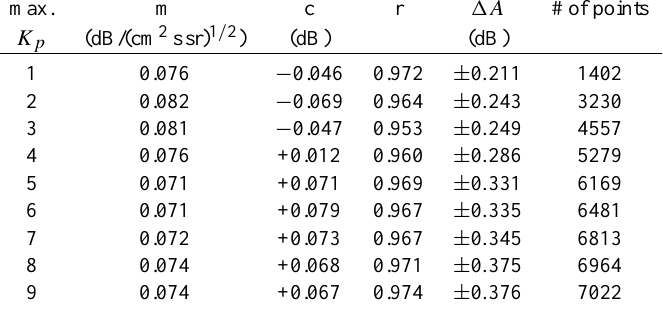
√ J(> 10 ) + c . Columns left to right display the maximum K p Table 3. Parameters of fits to the CNA and integral flux using the form: A = m of the data used, the gradient of the fit, the intercept, the correlation coefficient, least-squares fit error and the number of points used. max. m c r 1A # of points K p (dB/(cm 2 ssr) 1 / 2 ) (dB) (dB) 1 0.076 − 0.046 0.972 ± 0 . 211 1402 2 0.082 − 0.069 0.964 ± 0 . 243 3230